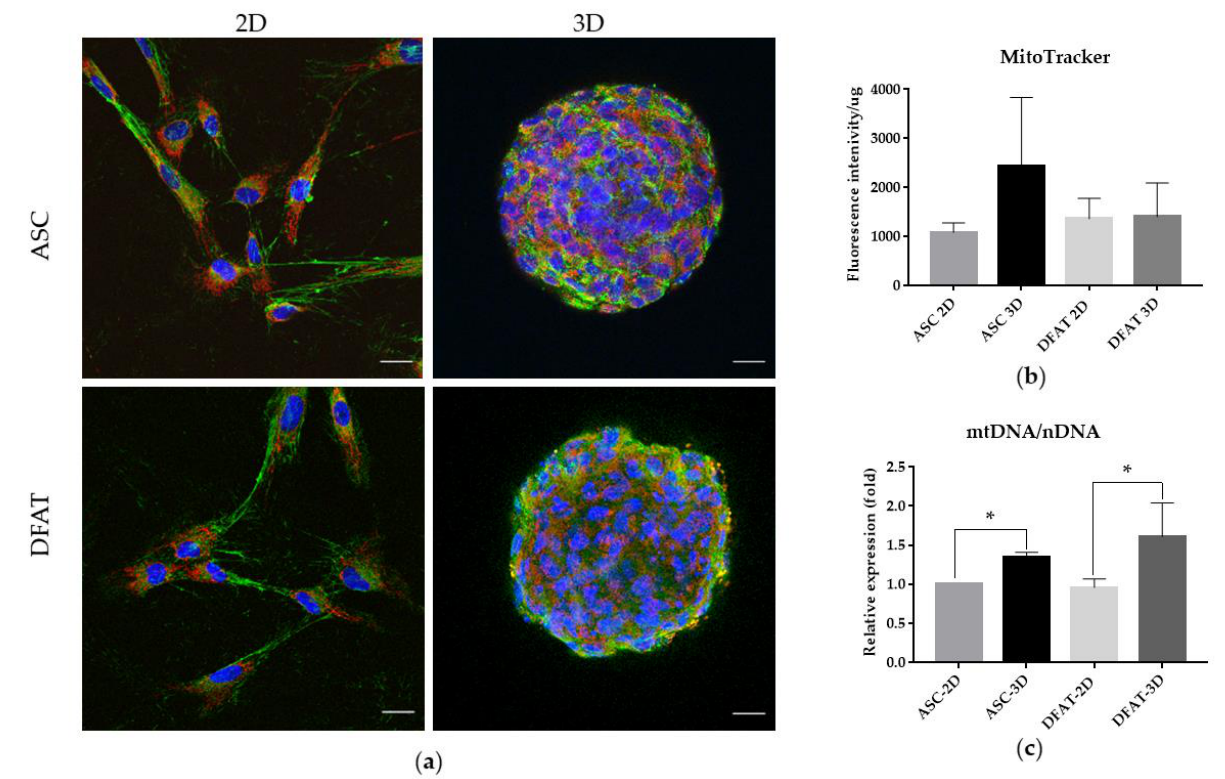
Figure 7. Comparative assessment of mitochondrial content in ASCs and DFATs cultured as a monolayer and spheroids ( a ) The immunocytochemical staining of mitochondria: Anti-mitochondria antibody (red) and Ani-Fibronectin antibody (green). Scale bar = 20µm. ( b ) MitoTracker™ FM fluorescence intensity ( c ) The mtDNA/nDNA ratio. The results are presented as mean values of three experiments ± SD and are normalized per µg of protein, for * p < 0.05.